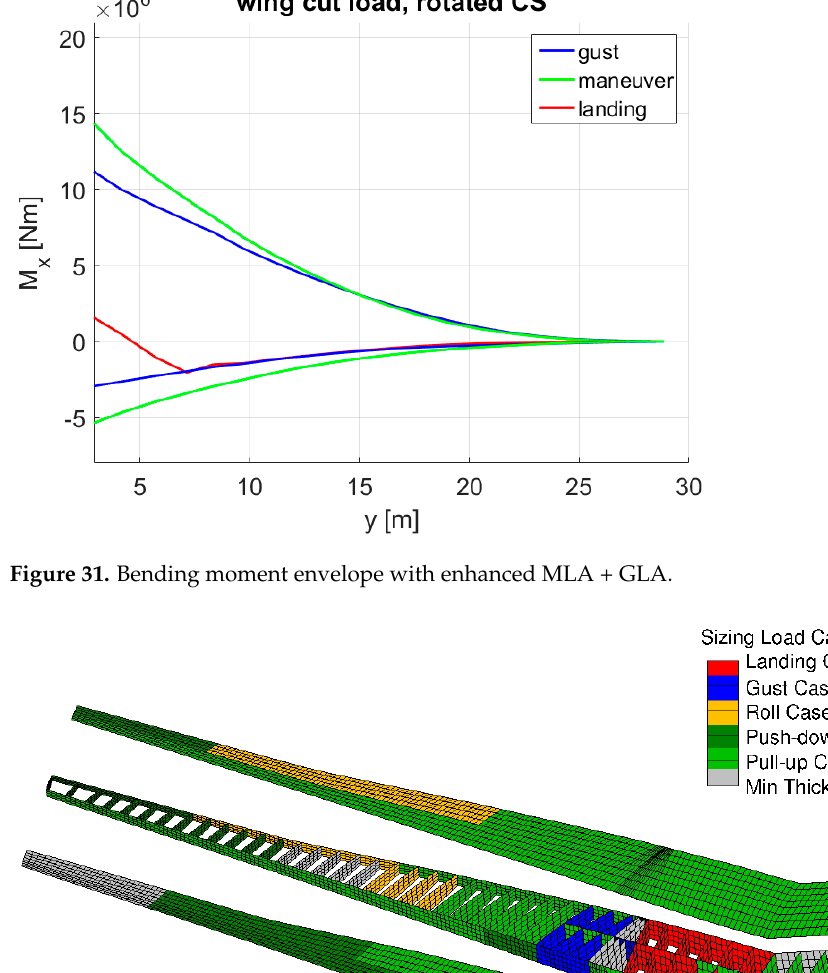
Figure 33. Material thickness distribution in m—enhanced MLA + GLA.